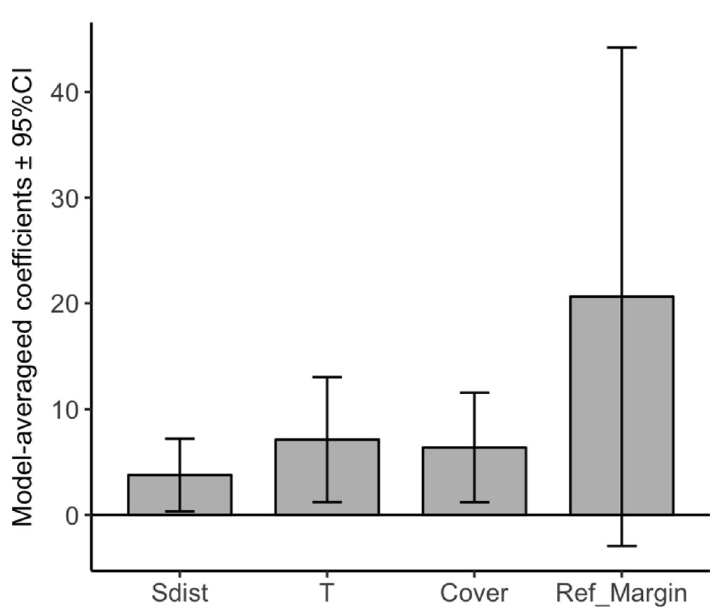
The correct legend for Fig. 4 is: “ Coef fi cient averages of the fi ve most important predictors with 95% con fi dence intervals. Models constructed using the full dataset (n = 1464). For details of the 30 competing models refer to Supplementary Table 3. All variables are scaled to allow direct comparison both in direction and in magnitude, ranked by importance (threshold = 0.6). Sdist: distance to mountain summit, T: baseline temperature, CCR: climate change rate, Cover: forest cover percentage.